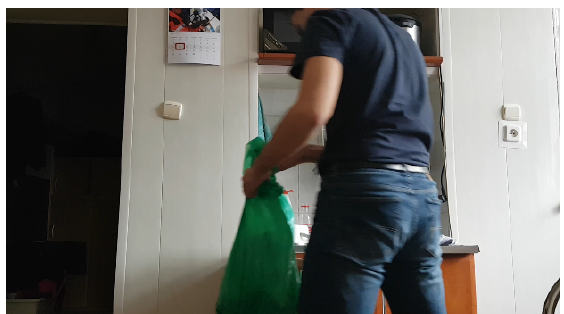
Figure 5. An exemplary frame used in the training process to detect the execution of a